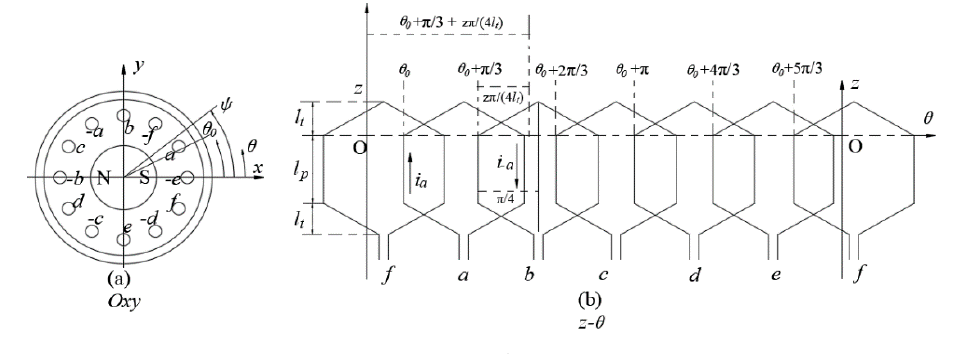
Figure 6. Coordinate axis.